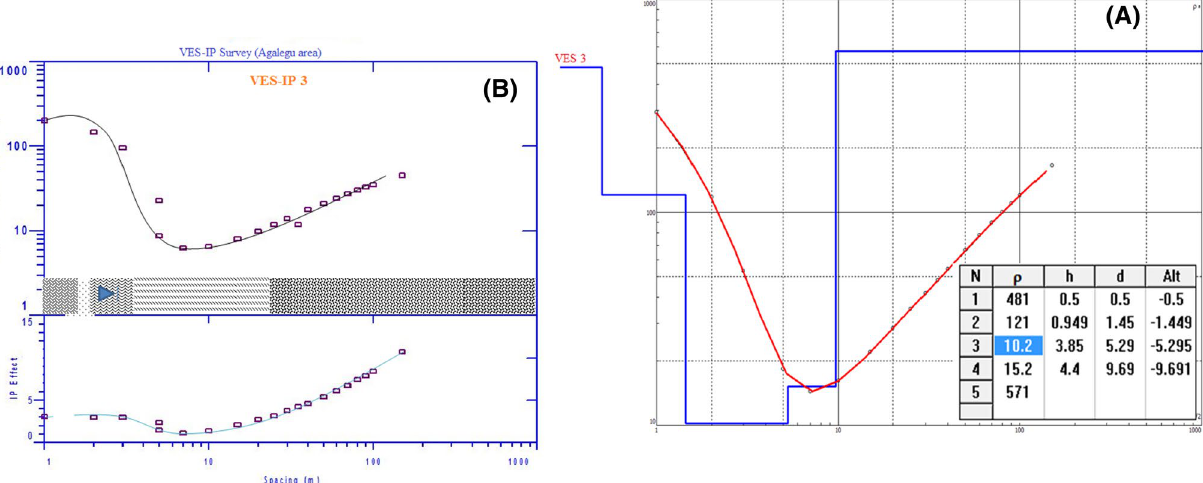
misfit exists between measured depth to water table from the borehole log and the depth marked from apparent resistivity